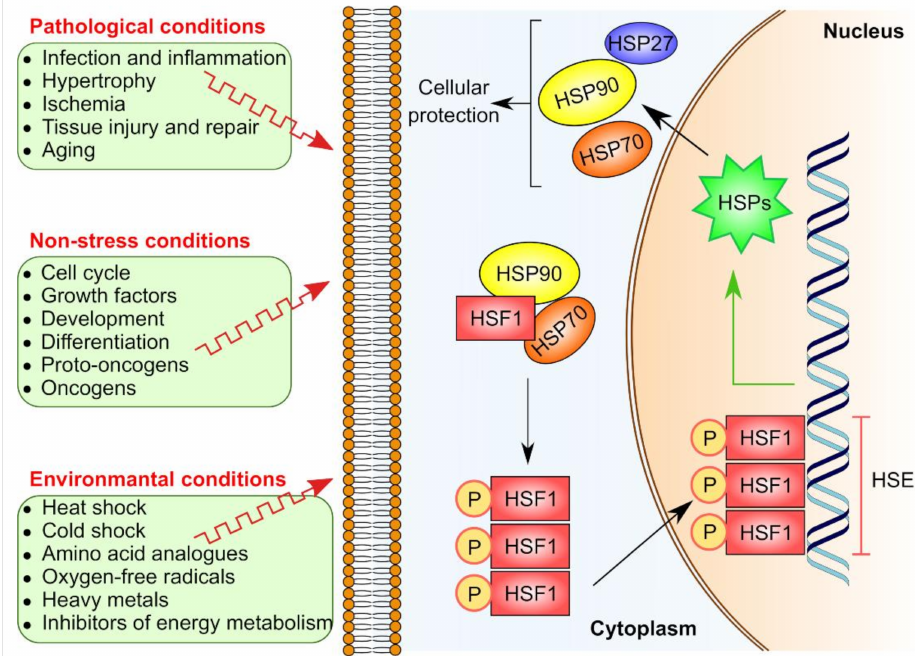
Figure 1. Induction of HSR by HSF1. Various factors including environmental, non-stress and pathological conditions can trigger HSP expression via HSF1 pathway. In non-activated state, HSF1 is sequestered in the cytoplasm due to its binding to chaperone complex including HSP70 and HSP90, thus prevented from performing its transcriptional activity. Upon activation, the chaperone complex dissociates and HSF1 is liberated, homotrimerizes and translocated to the nucleus. In the nucleus, the HSF1 homotrimer binds to the heat shock elements (HSEs) that are located upstream to heat shock gene promotors to initiate the transcription of its target genes including HSP genes.